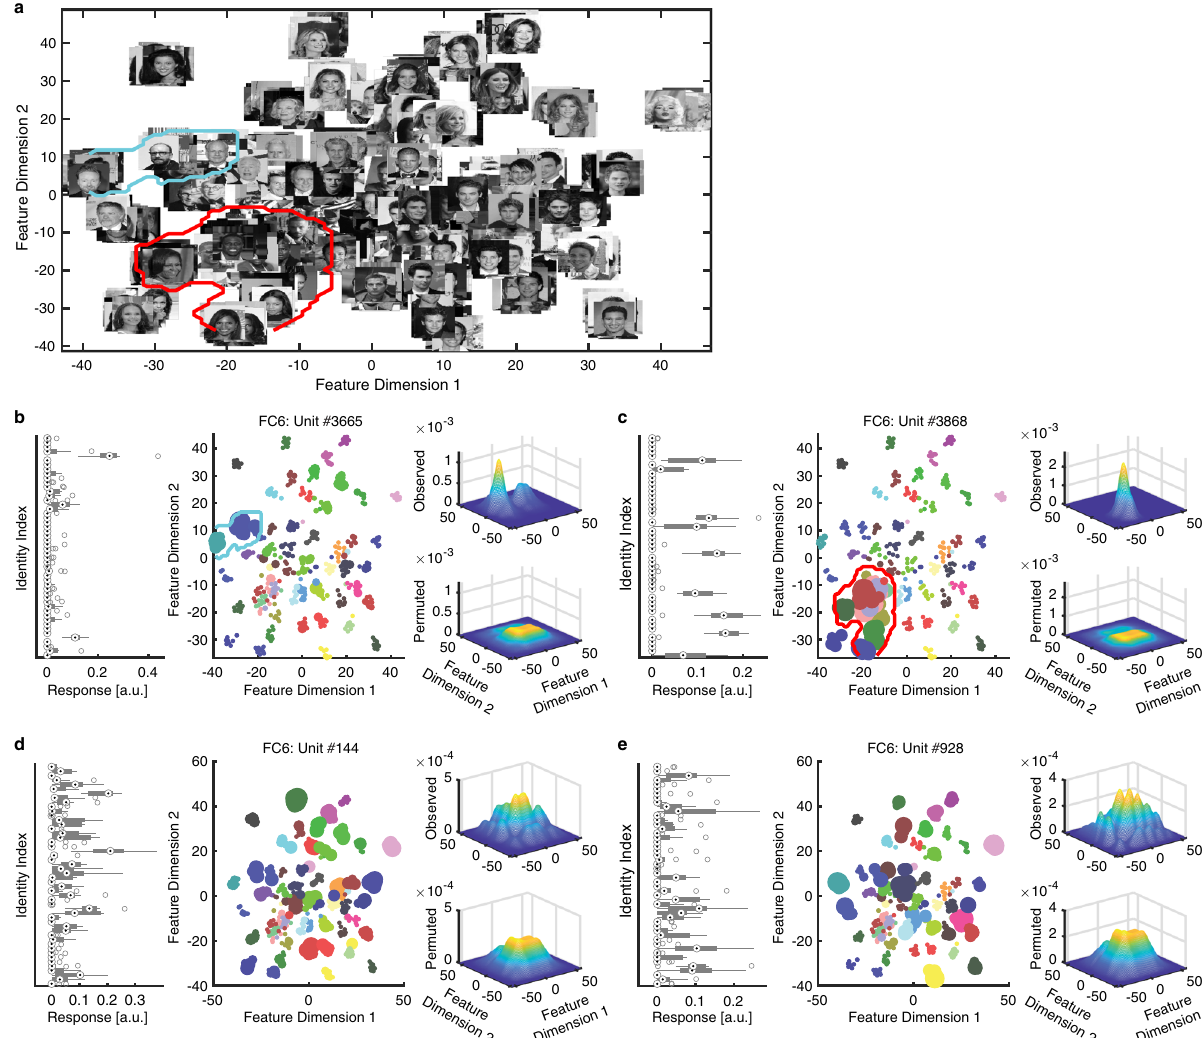
Fig. 7 Region-based feature coding in DNN units. a The face feature space constructed by t-distributed stochastic neighbor embedding (t-SNE) for the DNN layer FC6. All stimuli are shown in this space in grayscale. b – e Example DNN units. b , c Two examples of MI units that demonstrated region-based feature coding (i.e., the units encoded a region in the feature space). d An example MI unit that did not demonstrate region-based feature coding (i.e., the encoded identities were not adjacent to each other in the feature space). e A non-identity-selective unit (i.e., the unit did not encode any particular identities). All examples were from the DNN layer FC6. Left: Response of DNN units to 50 identities (500 faces in total; ten faces per identity) in arbitrary units (a.u.). On each box, the central mark is the median, the edges of the box are the 25th and 75th percentiles, and the whiskers extend to the most extreme data points the algorithm considers to be not outliers. Middle: Projection of the DNN activation onto the feature space. Each color represents a different identity. The size of the dot indicates the level of activation. Right: Estimate of the spike density in the feature space. By comparing observed (upper) vs. permuted (lower) responses, we could identify a region where the observed response was signi fi cantly higher in the feature space. This region was de fi ned as the tuning region of a unit (delineated by the red/cyan